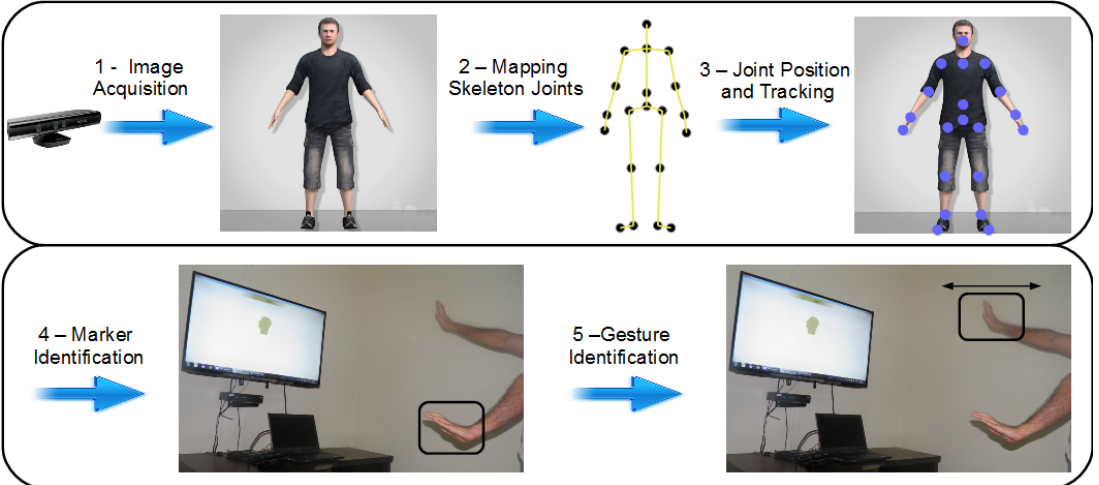
Fig. 5: Gesture recognition